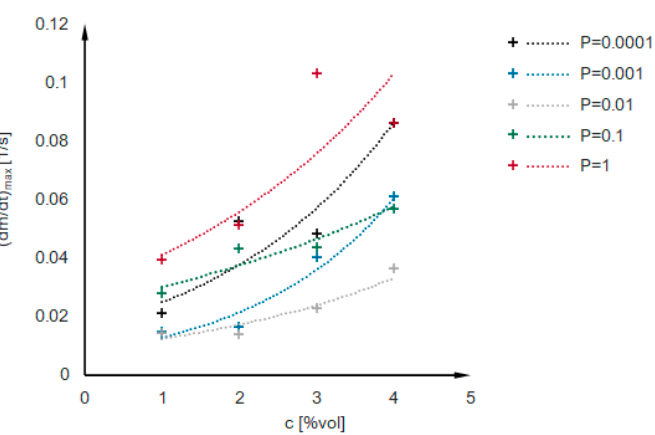
Figure 11. The dependence of the second phase duration on effective collision probability for var- iable concentrations of secondary particles in a system.